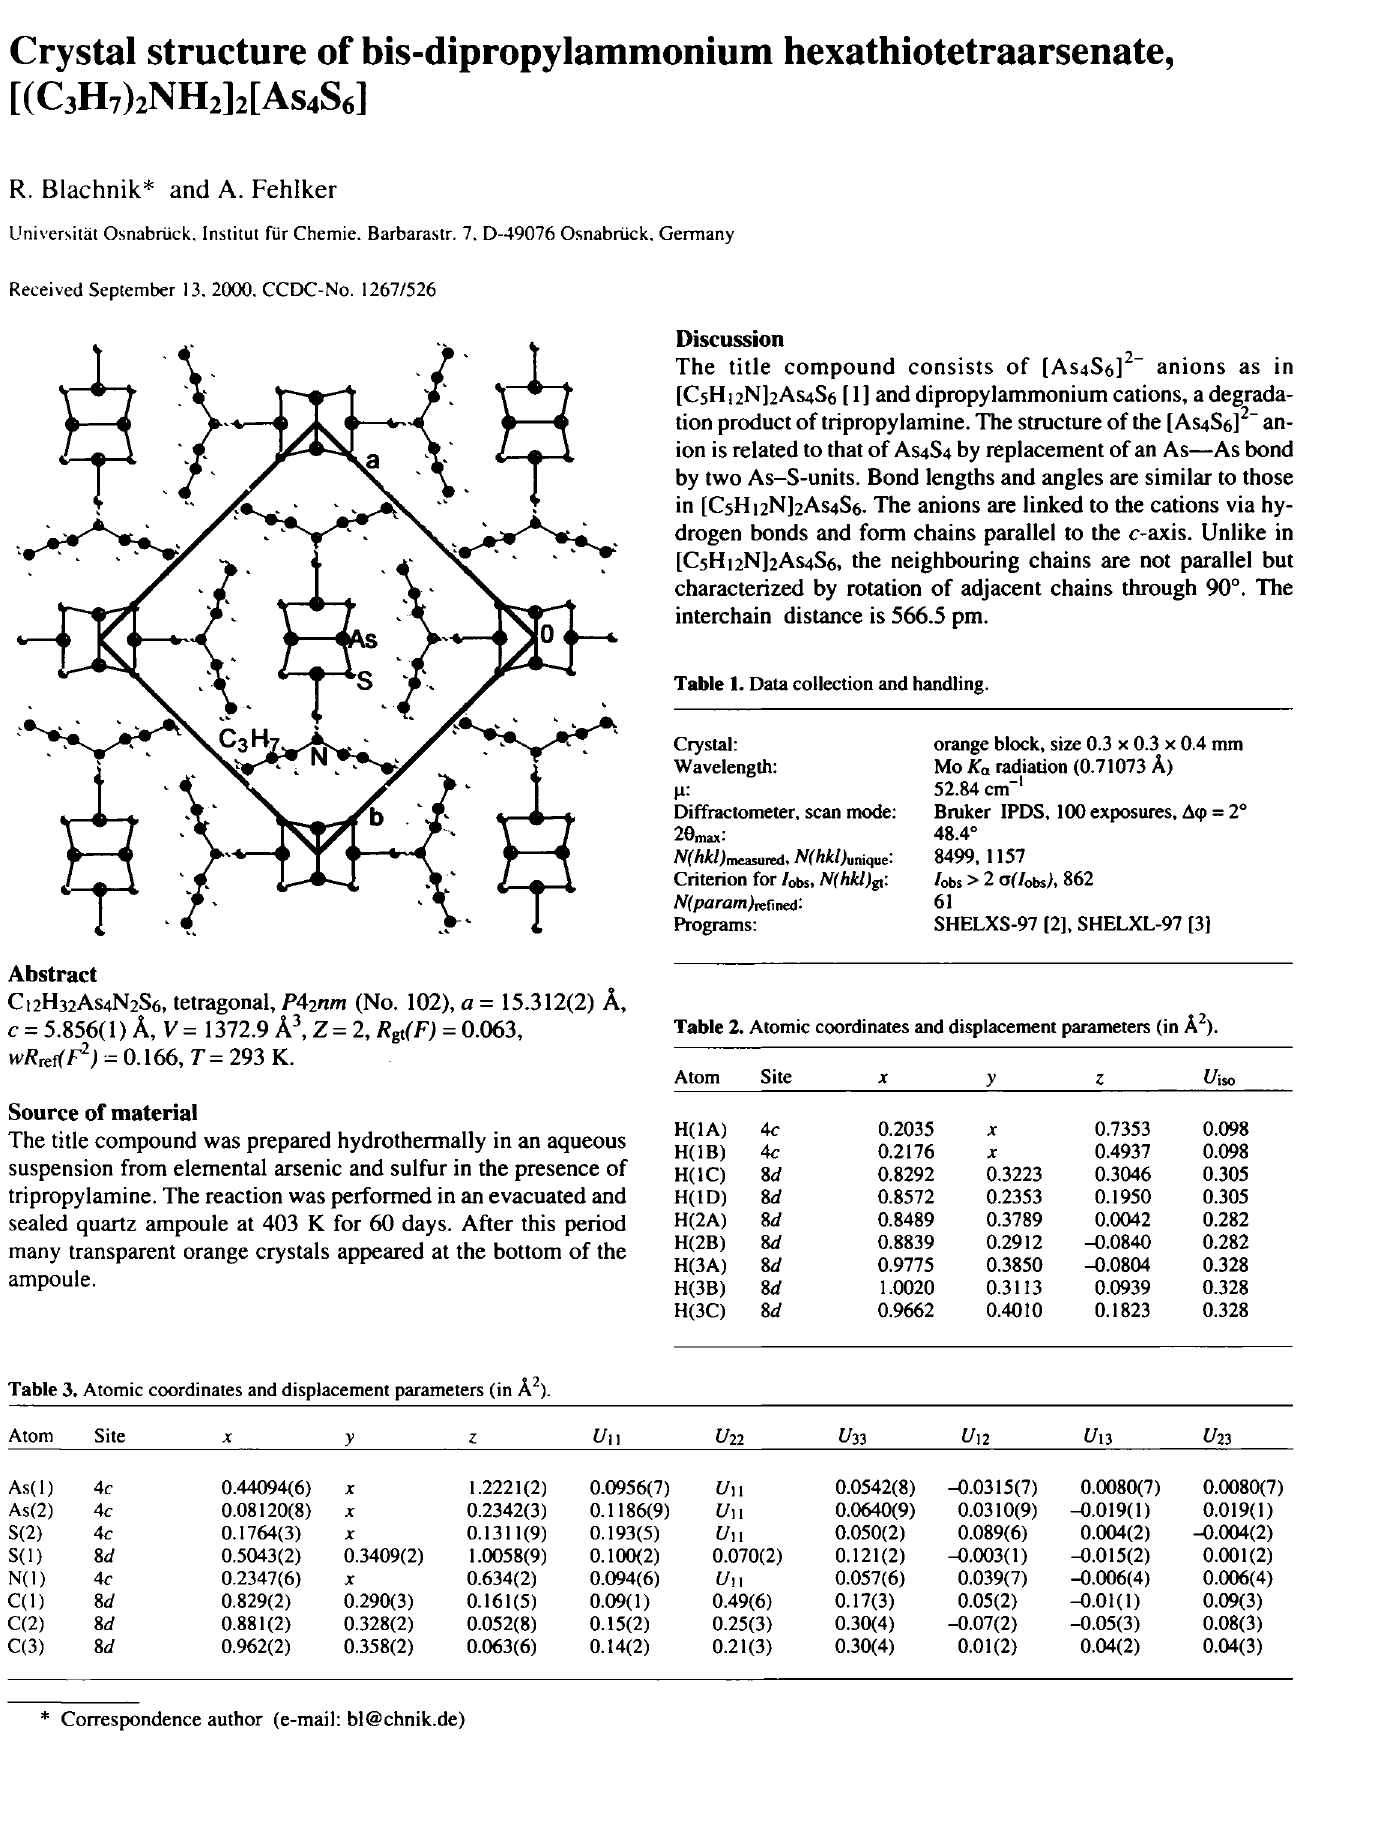
Table 3. Atomic coordinates and displacement parameters (in Ä 2 ).